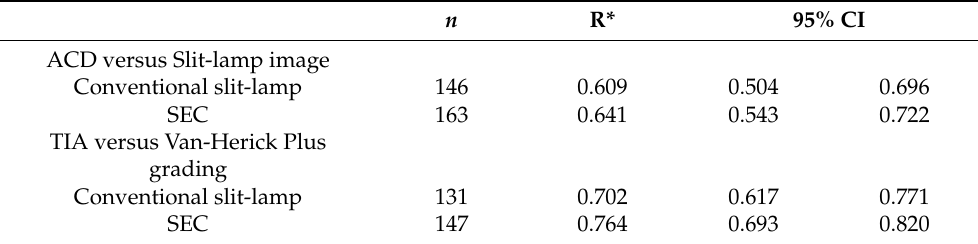
Table 4. Correlation between the AS-OCT findings and conventional slit-lamp or SEC